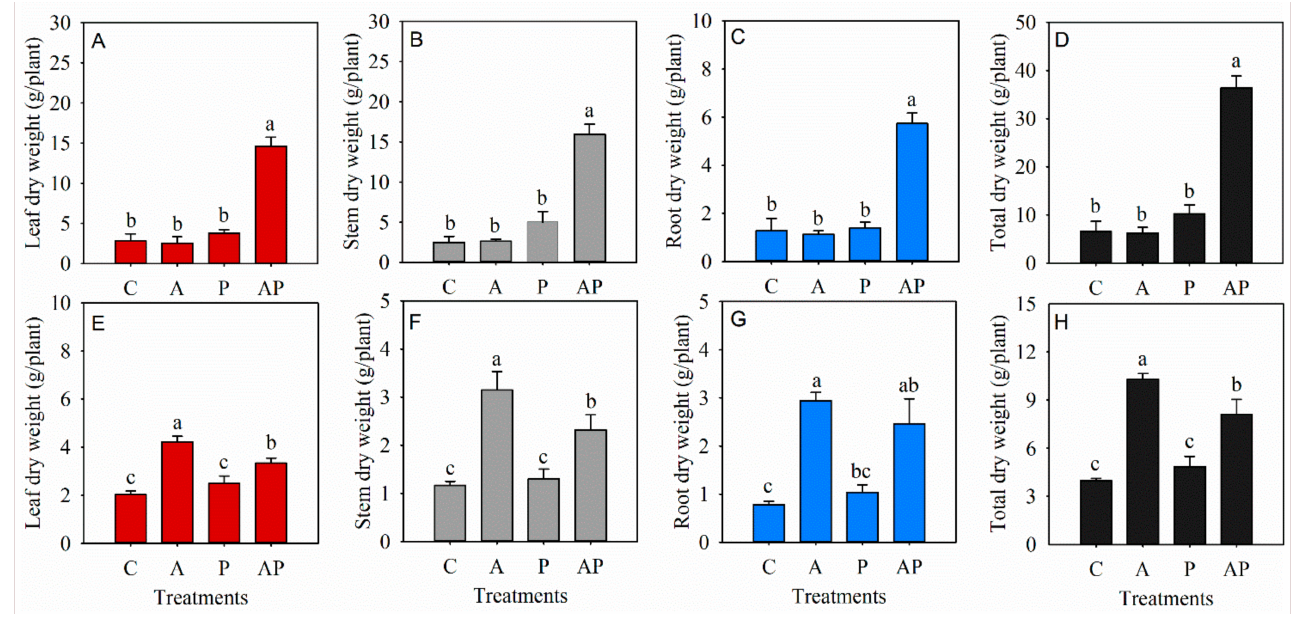
Figure 2. Effects of AMF and PGPR inoculation on the leaf dry weights ( A , E ), stem dry weights ( B , F ), root dry weights ( C , G ), and total dry weights ( D , H ) in Nitraria tangutorum Bobr. (first row) and Elaeagnus angustifolia Linn. (second row). Each value represents the mean of three replicates. Each bar represents the standard deviation of three replicates. Values are significantly different at the 0.05